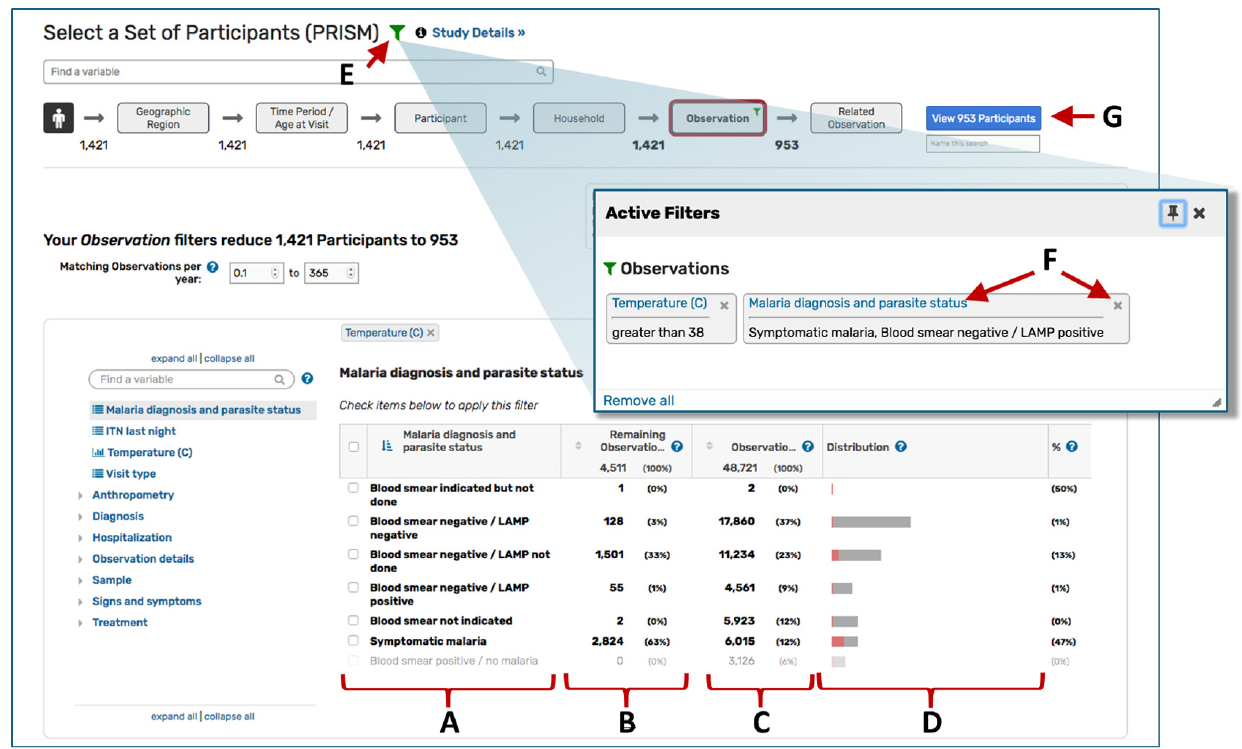
Figure 3. Adding, editing, and removing filters. Categorical data are displayed in a table and (A) can be selected via check boxes next to the values. (B) The “Remaining” column indicates the data remaining given all other data selections (including selections in upstream steps), while the (C) Observations column indicates the total counts for all data. (D) For both continuous and categorical variables, data that meet the filter criteria (“remain”) are shown in red on the distribution graph while data that do not meet the filter criteria are shown in grey. (E) Clicking the green filter icon brings up a box that lists all applied filters. (F) Users can click the blue link to edit a filter or the “x” to remove it. (G) The blue button takes the user to the results